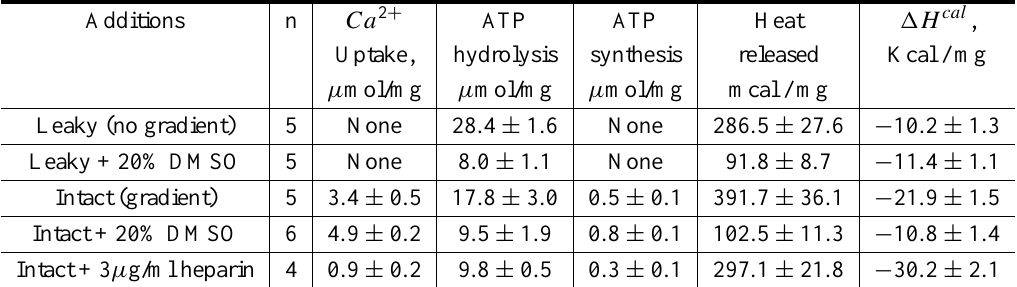
Ca 2 + Uptake, ATP hydrolysis, ATP synthesis and heat production by rabbit sarcoplasmic reticulum vesicles.